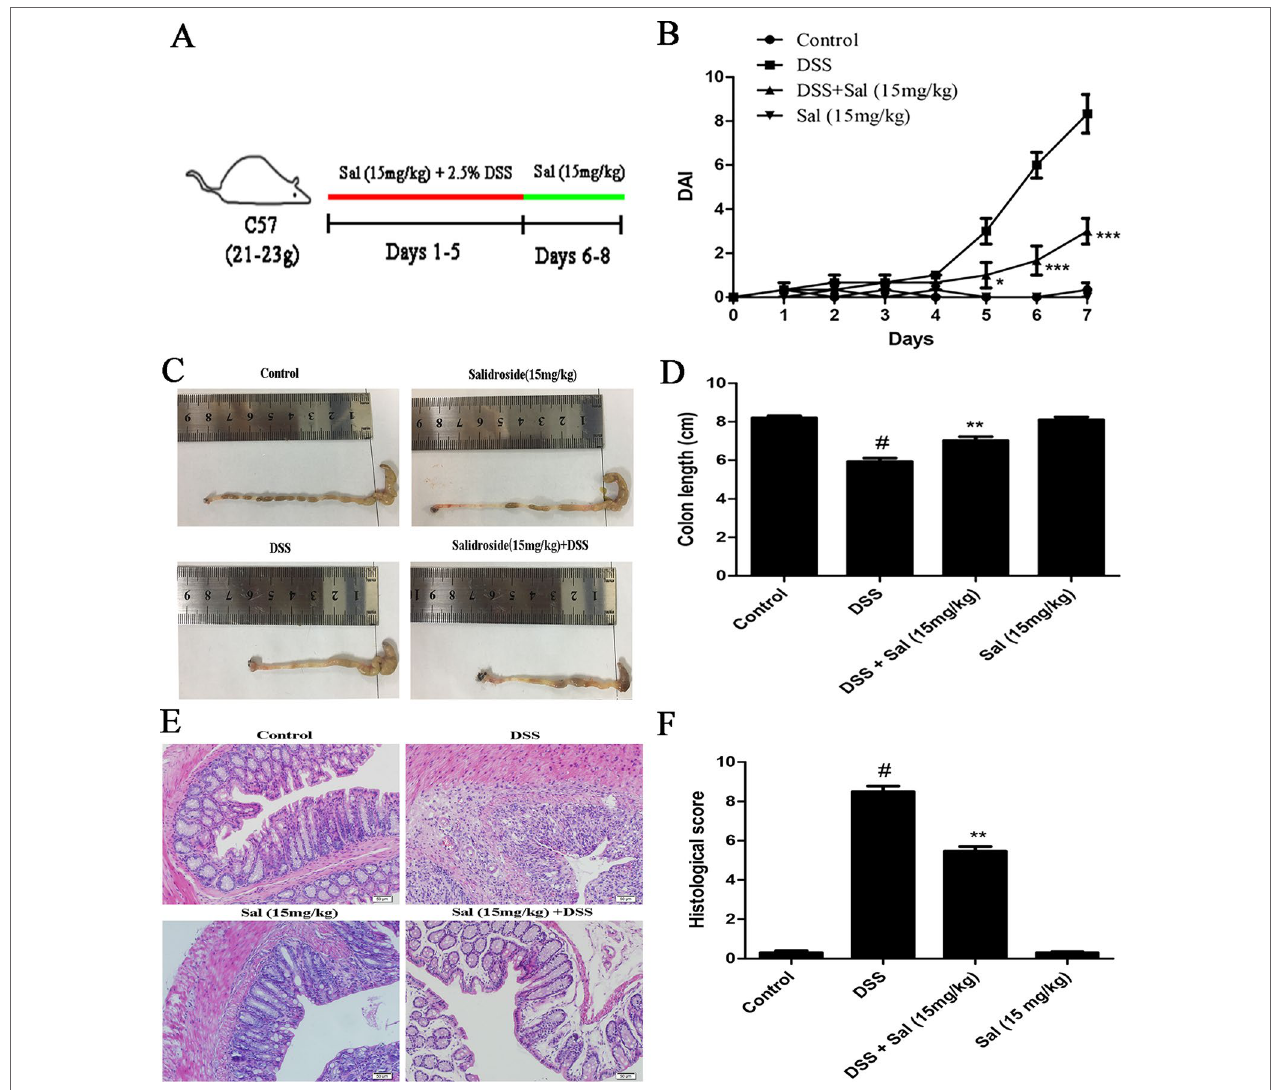
FIgURe 1 | Salidroside alleviated dextran sulfate sodium (DSS)-induced colitis in mice. (A) The schematic diagram of DSS-induced colitis in mice treated with Sal (15 mg/kg). (B) Disease activity index (DAI) during the experimental process. (C) and (D) , the photos and statistical results of colon length, respectively. (e) Histopathological section of colon from each experimental group (200×; scale bar, 50 μm). (F) Histopathological scores of each group were calculated. Data were presented as the means ± SD. (*) p < 0.05, (**) p < 0.01, and (***) p < 0.001 vs . the DSS-treated group; ( # ) p < 0.05 vs . the control group.